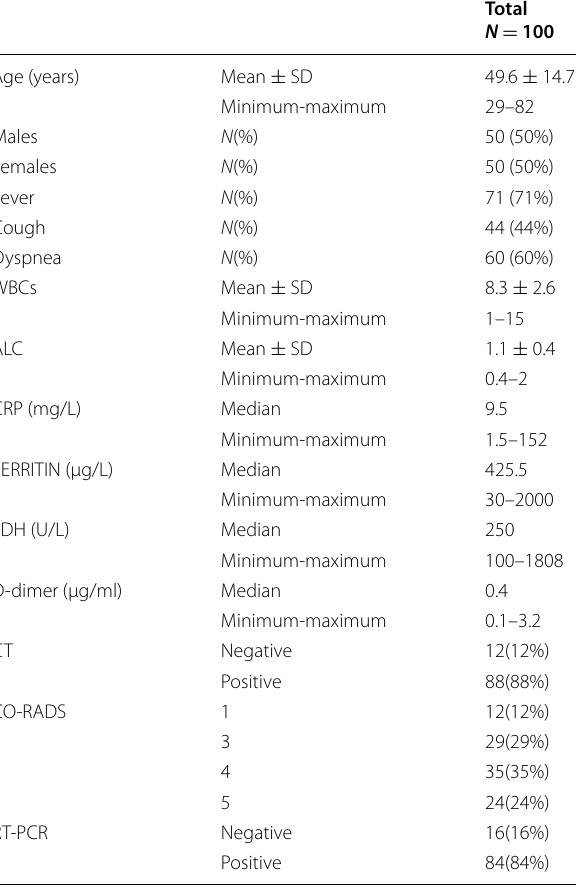
Table 2 Patients’ features Table 3 Comparison of studied parameters between negative and positive